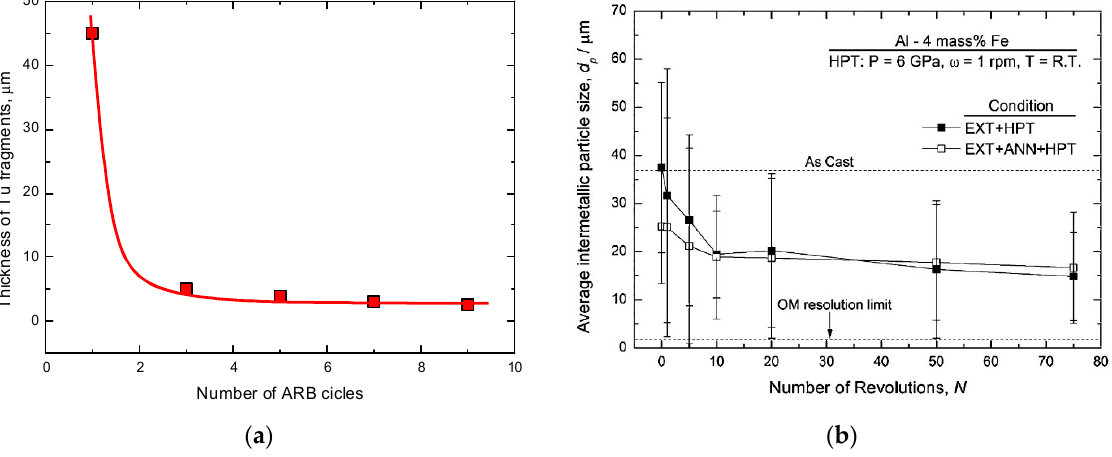
Figure 10. ( a ) Dependence of mean thickness of Ti layers/fragments within the Cu matrix on the number of ARB cycles estimated from the data published in refs. [87–93]. The lines are the guides for the eye. ( b ) The dependence of size d of Al 3 Fe intermetallic particles in the Al — 4 wt.% Fe alloy on the number of HPT rotations n . d ( n ) curves are shown for two cases, namely for the samples after extrusion and annealing followed by HPT (EXT + ANN + HPT, open squares) and for the alloys after extrusion followed by HPT (EXT + HPT, solid squares). Reprinted with permission from ref. [90]. Copyright 2012 Elsevier.